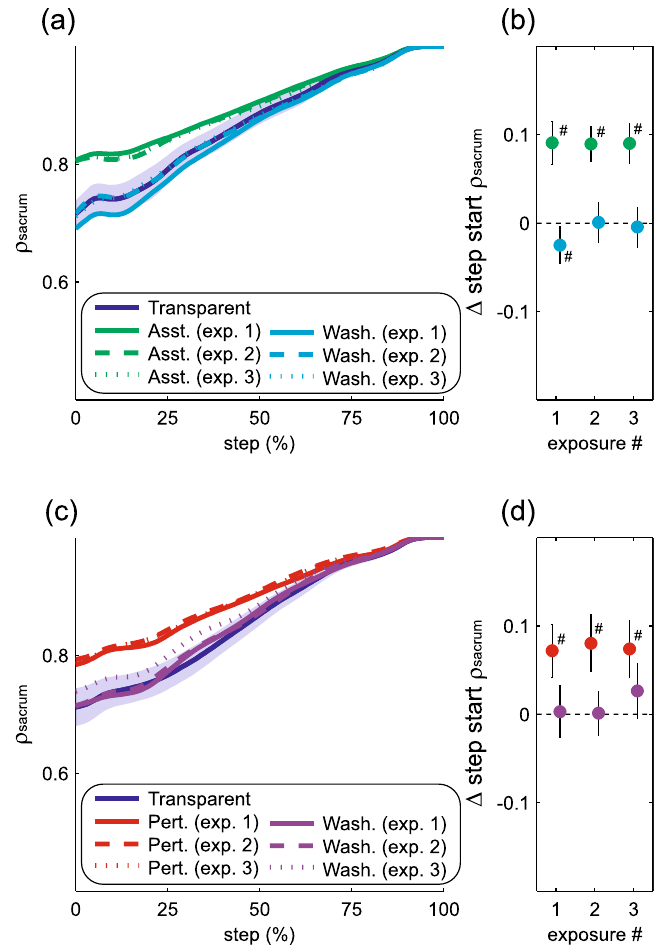
Figure 9. Effects of repeated force-field exposures and washout periods on the partial correlation between mediolateral pelvis displacement throughout a step and mediolateral pelvis displacement at the end of the step (ρ sacrum ). The top row ( a – b ) illustrates gait metrics during and following force-field assistance, while the bottom row ( c – d ) illustrates these metrics during and following perturbations. The general structure of the figure follows Fig. 8. For all comparisons, the first 225 steps of each exposure are